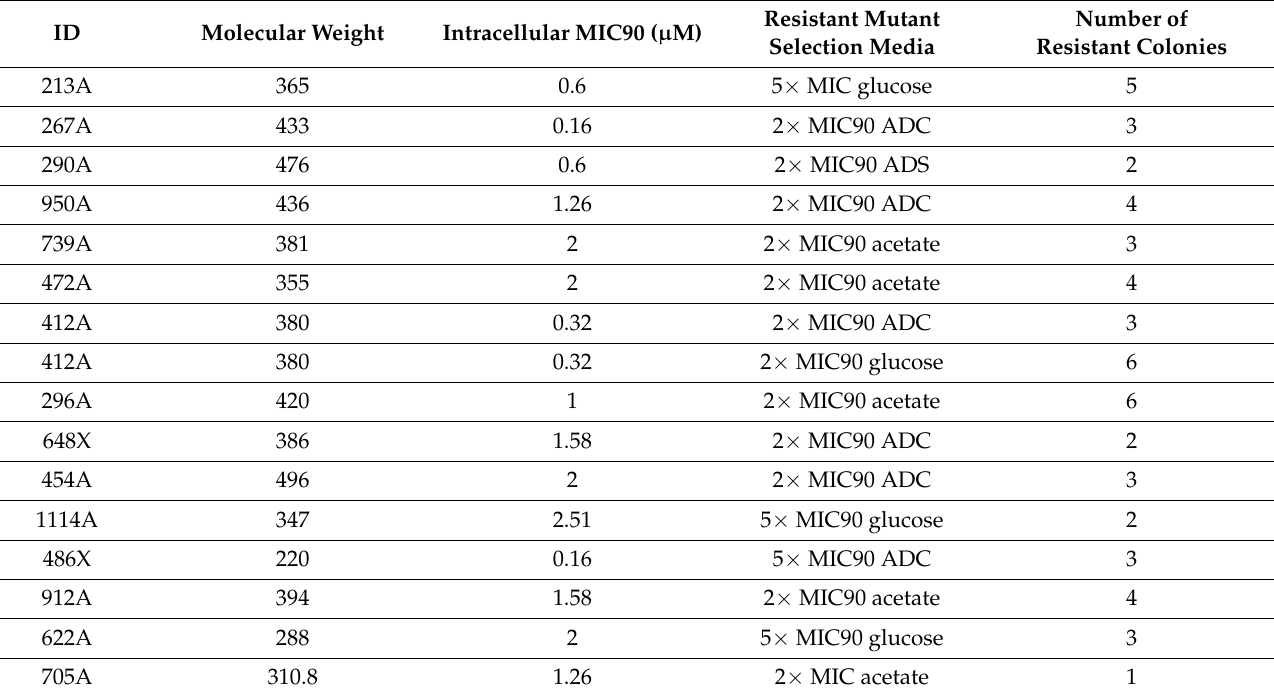
Table 1. Characteristics of the chemical compounds and conditions for mutant